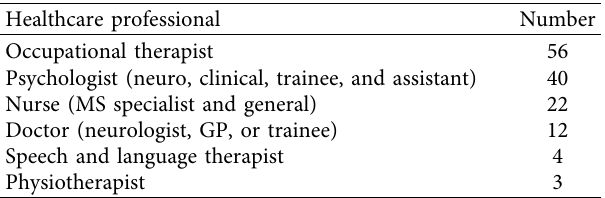
Figure 3: Assessments used by healthcare professionals to assess cognition in people with MS. ∗ The MACFIMS consists of SDMT, PASAT, CVLT2, BVMTR, COWAT, JLO, and DKEFS sorting but is listed as a battery of assessments here. ∗∗ The BICAMS consists of SDMT, CVLT2, and BVMTR but is listed as a battery of assessments here. Table 4: Healthcare professionals conducting cognitive asses- sment ∗